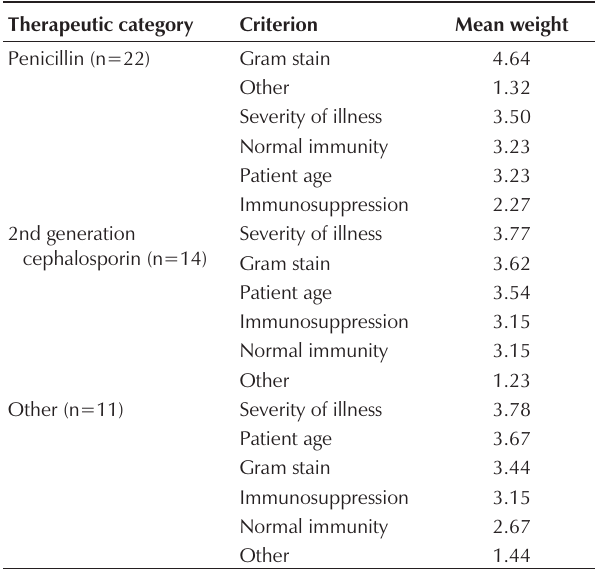
Mean corrected weights assigned to Likert scales of case 2 (closed-ended questionnaires) by therapeutic category